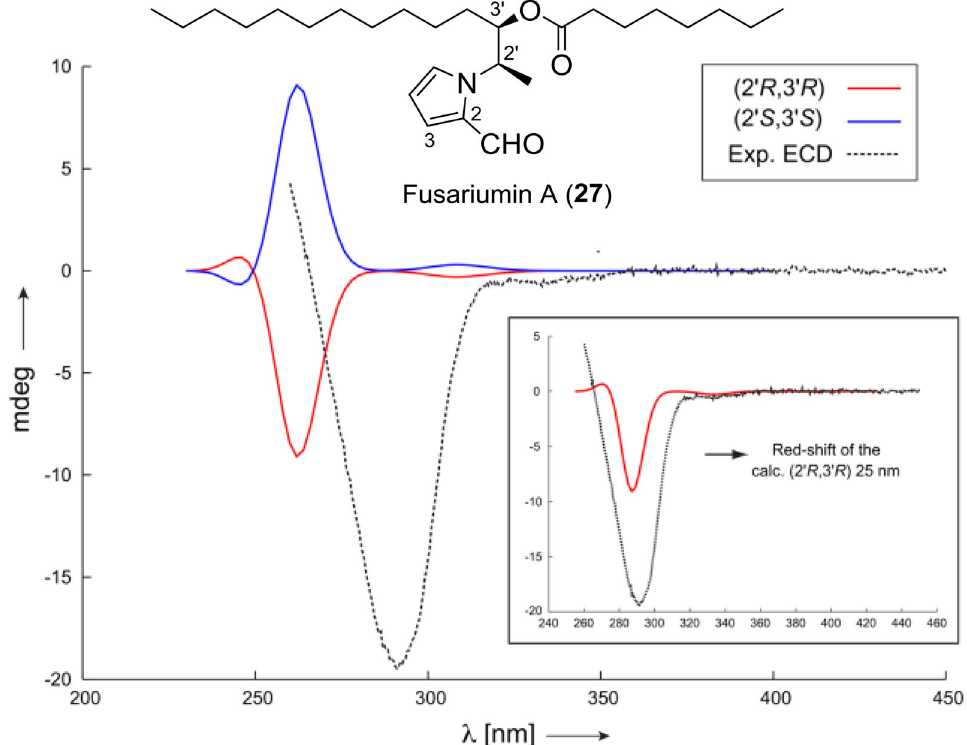
Fig. 7 Schematic representation of the steps involved in determina- tion of natural product stereochemistry by RDC analysis. ( a ) Structure of vatiparol ( 17 ). ( b ) Comparison between the gels for 1.7 and 5 mm NMR tubes. ( c ) The 1 D C–H values are extracted as the difference of